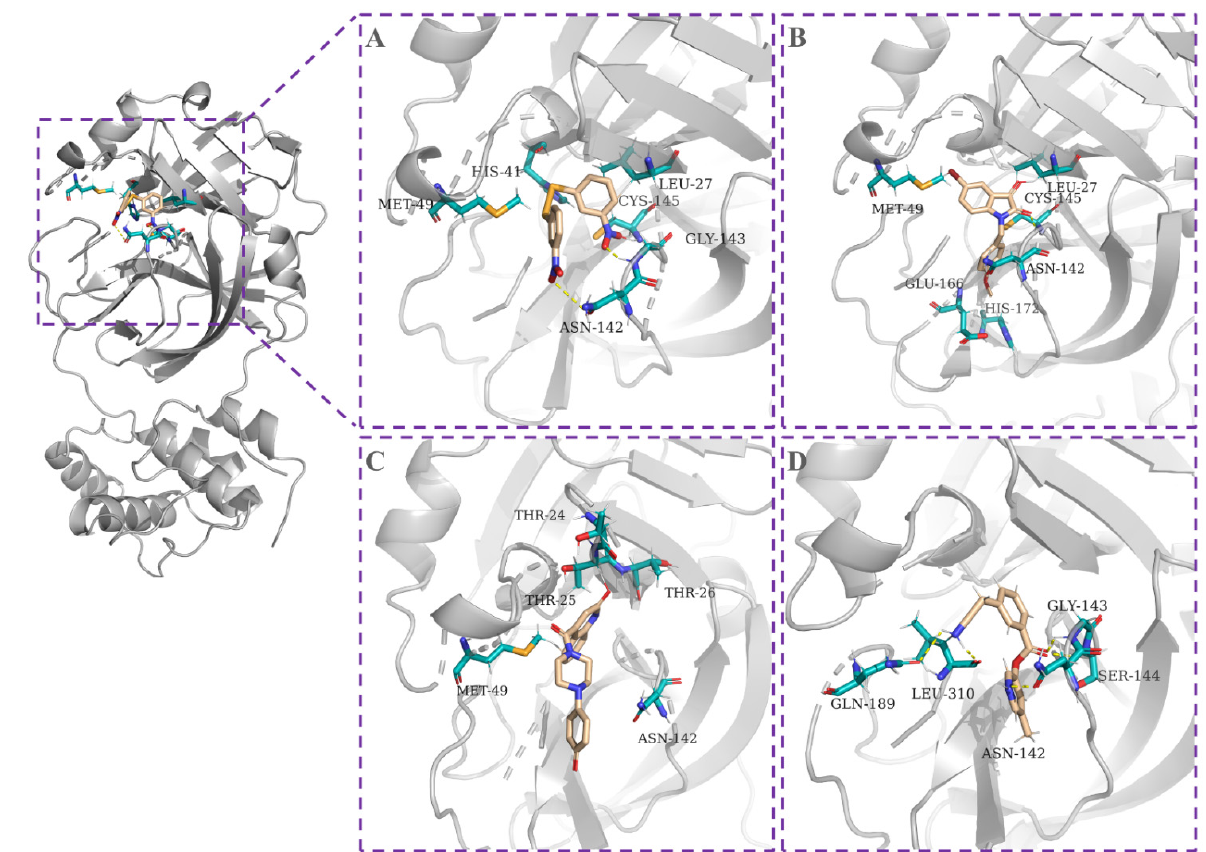
Figure 5. Molecular docking of predicted inhibitors to SARS-CoV-2 3CLpro. ( A ) Z56899184, − 8.67 kcal/mol; ( B ) Z57728899, − 7.86 kcal/mol; ( C ) Z57013003, − 7.45 kcal/mol; ( D ) Z1245218850, − 8.41 kcal/mol. 3CLpro is represented as translucent gray cartoon. The involved amino acids are represented in cyan.